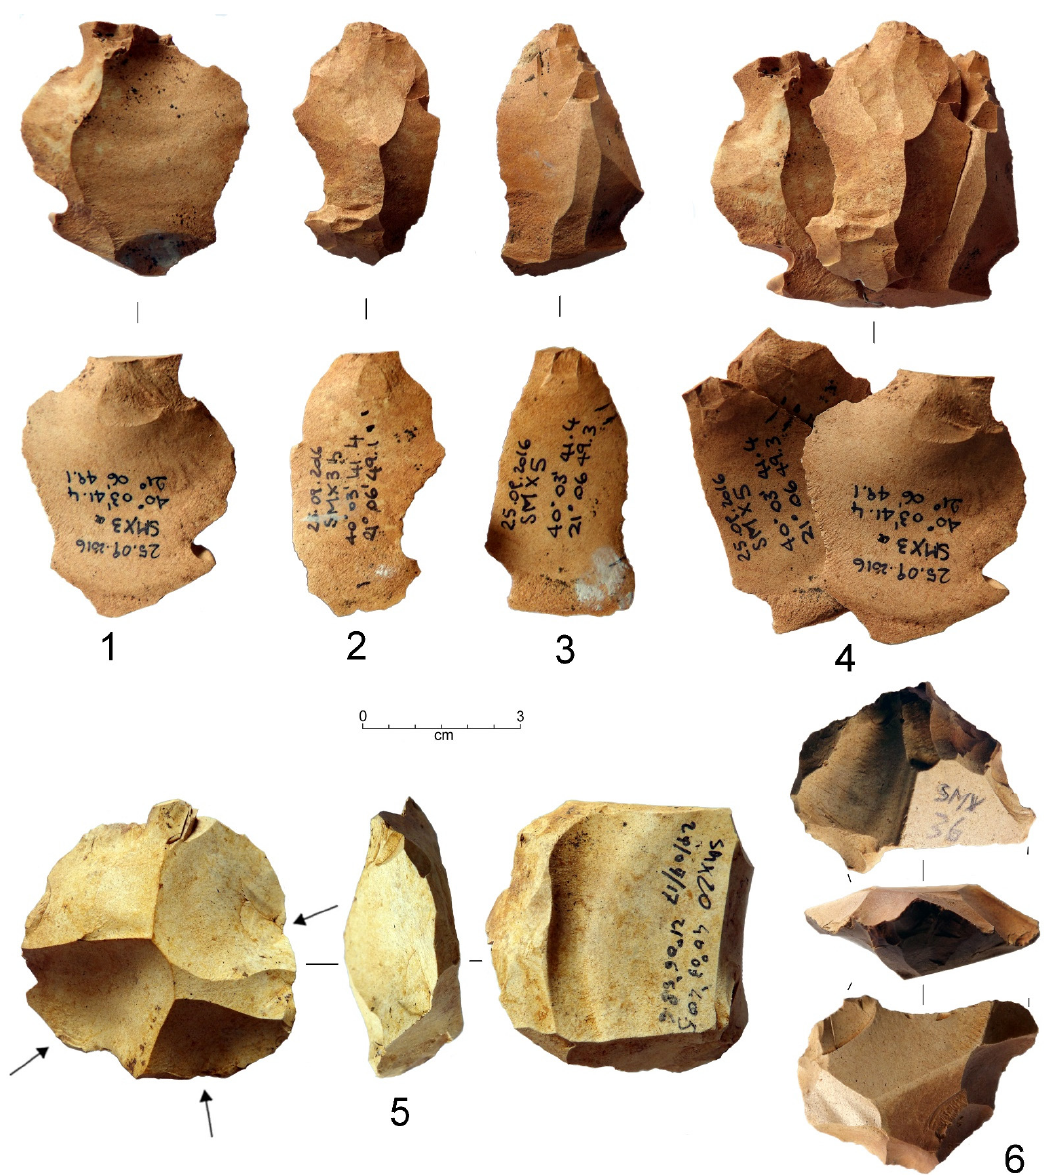
Figure 20. Lake Smixi: Middle Palaeolithic, Levallois refitting flakes (nn. 1–4) and discoid cores made from local chert (nn. 5 and 6) from the Smixi Member moraines south of the small basin (photographs by E. Starnini).